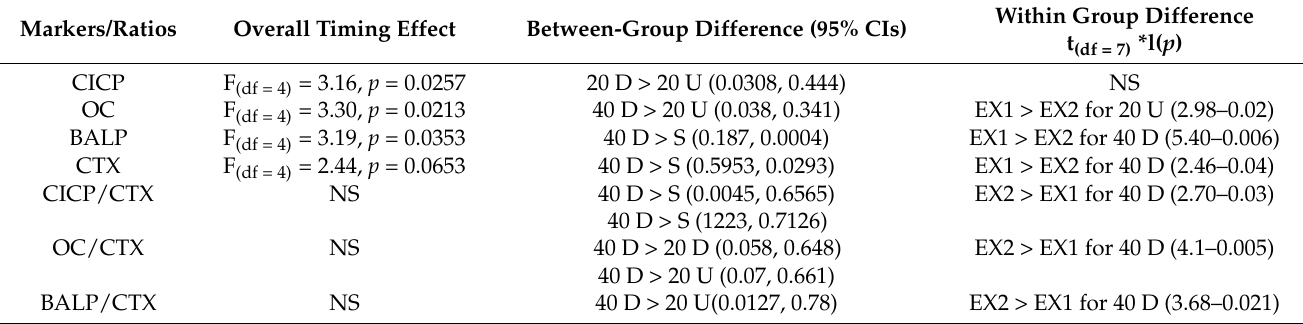
Table 5. Between group and within-group timing differences in exercise AUCs.